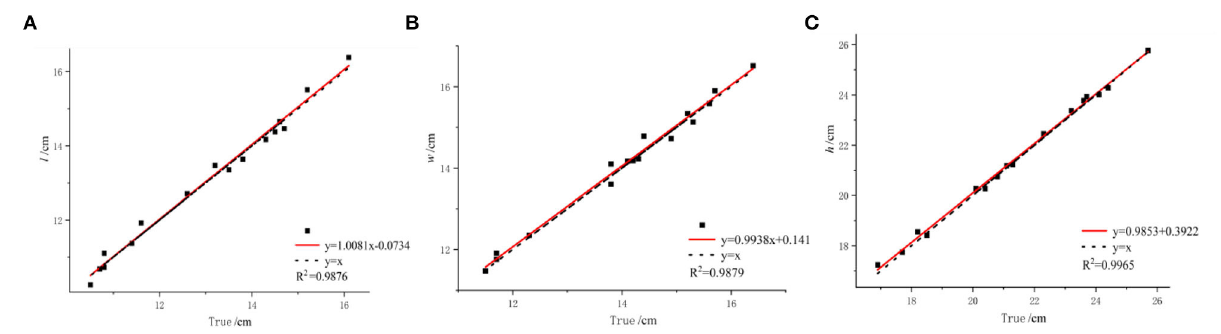
FIGURE 13 | Analysis of estimated grape bunch size. (A) Comparison of measured and estimated lengths. (B) Comparison of measured and estimated widths. (C) Comparison of measured and estimated